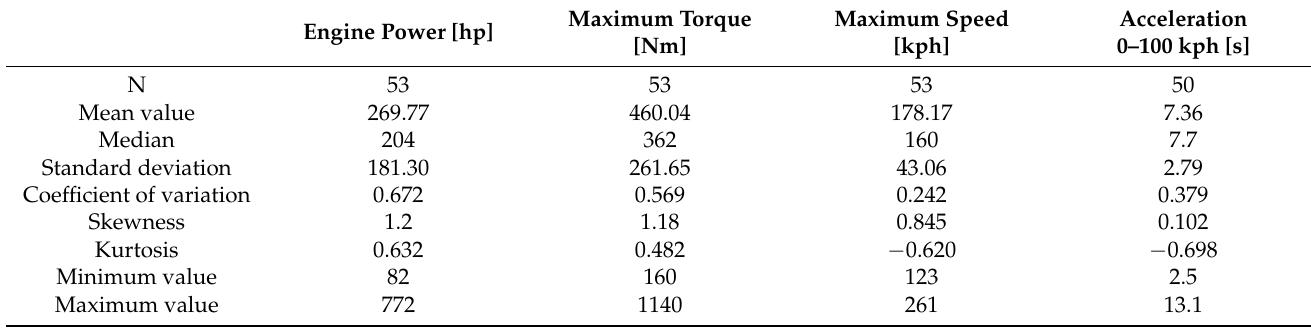
Table 4. Descriptive statistics for the extracted performance